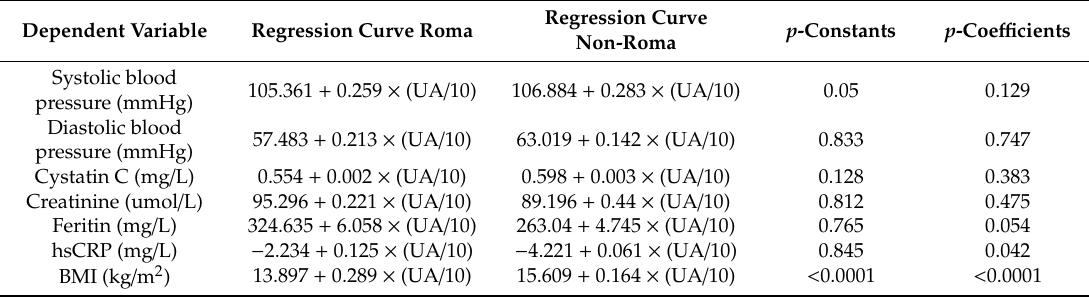
Table 5. The comparison of regression curves for variables significantly associated with uric acid in the Roma and non-Roma subgroups.